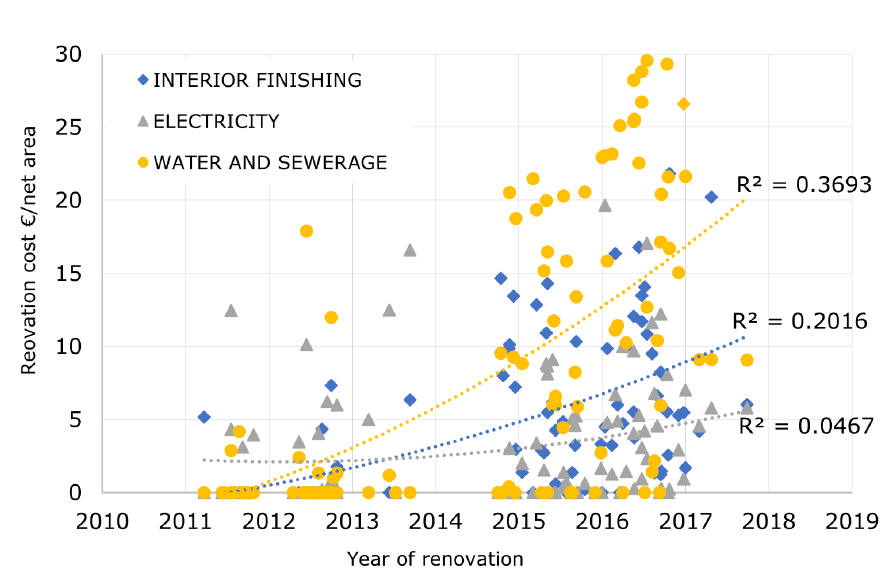
Figure 4. Cost of added renovation works during second grant scheme